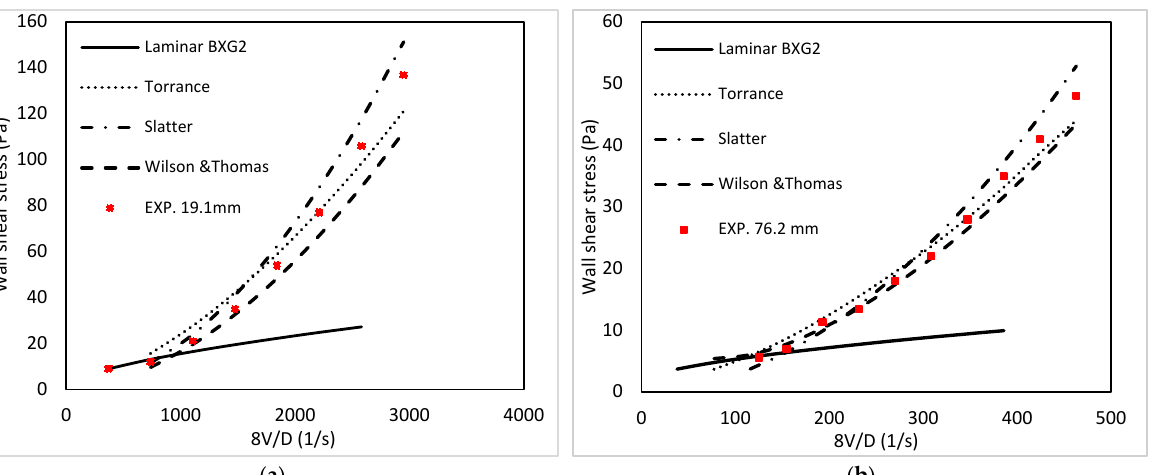
Figure 9. Comparison between predictions and experimental data of turbulent flow for high- concentrated CMC4 power-law fluid: ( a ) pipe diameter 19.1 mm, ( b ) pipe diameter 76.2 mm. The theoretical predictions were compared to the experimental results of turbulent flow behaviour for Herschel–Bulkley fluids in Figures 10 and 11 with two different rheology parameters in small and large pipe flow loops. When using the Herschel–Bulkley model, flow results for the BXG2 fluid are shown in Figure 10 for a pipe diameter of 19.1 mm (a) and a pipe diameter of 76.2 mm (b). Within the low effect of yield shear, the Slatter [21] method provided good estimates, while the accuracy increased with the increase in pipe diameter with a mean absolute relative error of 8.8% in Figure 10a and of 5.1% in Figure 10b.